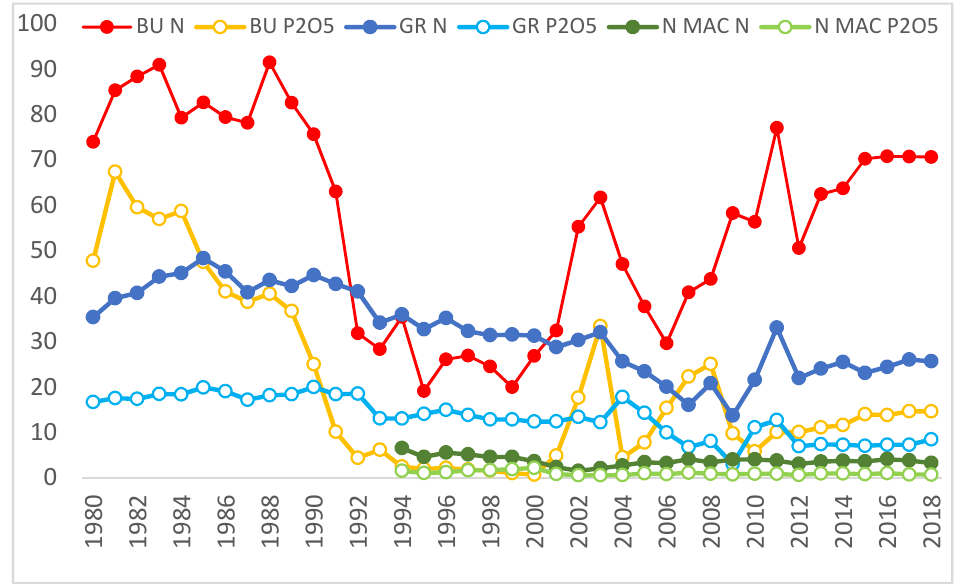
Figure 4. Total nitrogen (N) and phosphorous (P 2 O 5 ) fertilizer application (t/yr) in Greece, Bulgaria, and North Macedonia during 1980–2018 (data [54]).